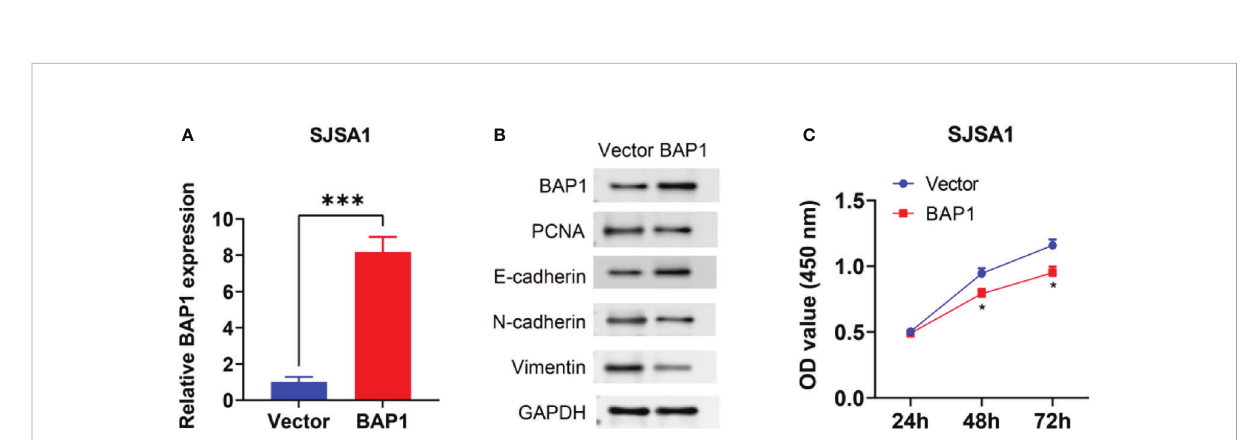
FIGURE 11 BAP1 overexpression inhibited SAOS2 cells growth and EMT. (A) BAP1 expression after BAP1 overexpression detected by qPCR. (B) The protein expression of BAP1, PCNA, E-cadherin, N-cadherin, and Vimentin after BAP1 overexpression. (C) The viability of SAOS2 cells after BAP1 overexpression detected by CCK-8. ***p <